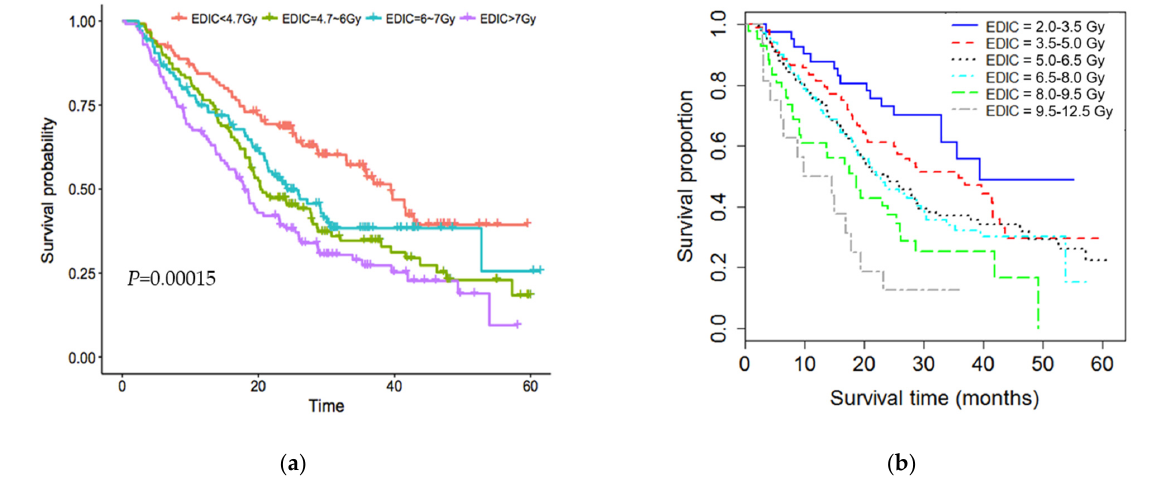
Figure 1. Overall survival curves separated by the effective dose to immune cells (EDIC). ( a ) for patients divided into 4 quartiles according to the EDIC); and ( b ) for patients divided into 6 EDIC groups with a 1.5 Gy dose increment. Survival improved significantly with a reduction in the EDIC. However, overall survival (OS) were not significantly different among patients with an EDIC between 6.0 and 8.0 Gy.